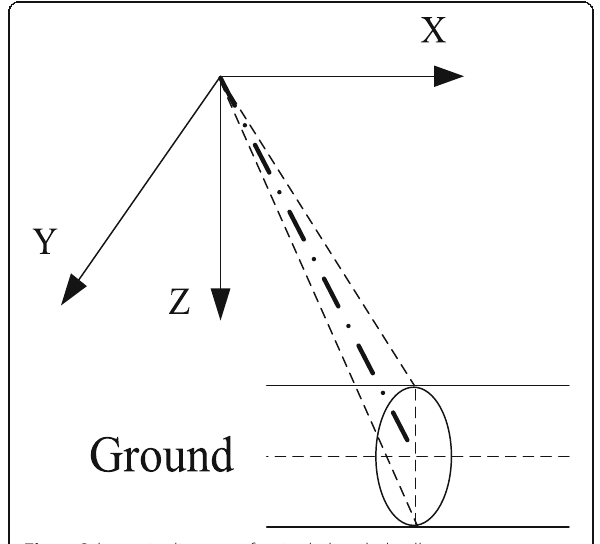
Fig. 1 Schematic diagram of a single banded cell